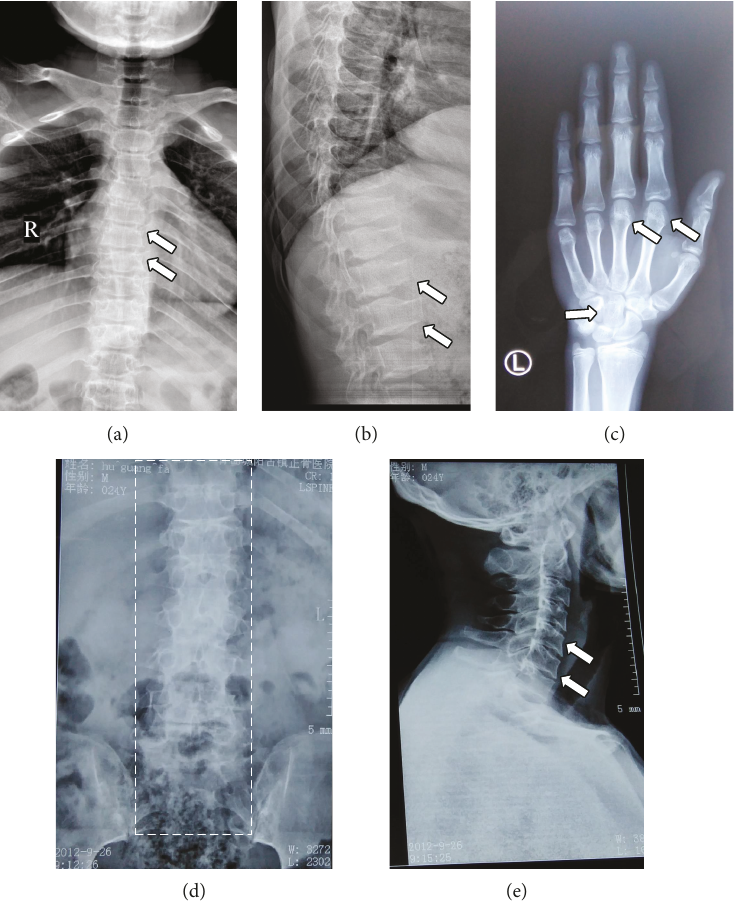
Figure 2: Radiographs of the patients of kindred members. The X-ray fi ndings of the proband were as follows. (a, b) Thoracolumbar anteroposterior position; the arrows indicate anterior superior and inferior edge depression, posterior hump protuberance, and milk bottle sign. (c) Lefthand positive position, interphalangeal joint enlargement as shown by arrow, carpal fusion. (d, e) The X-ray fi ndings of the proband ’ s uncle. (d) Total spinal position, scoliosis. (e) Cervical vertebrae lateral position; the arrows indicate superior and inferior edges of vertebral body depression, milk bottle